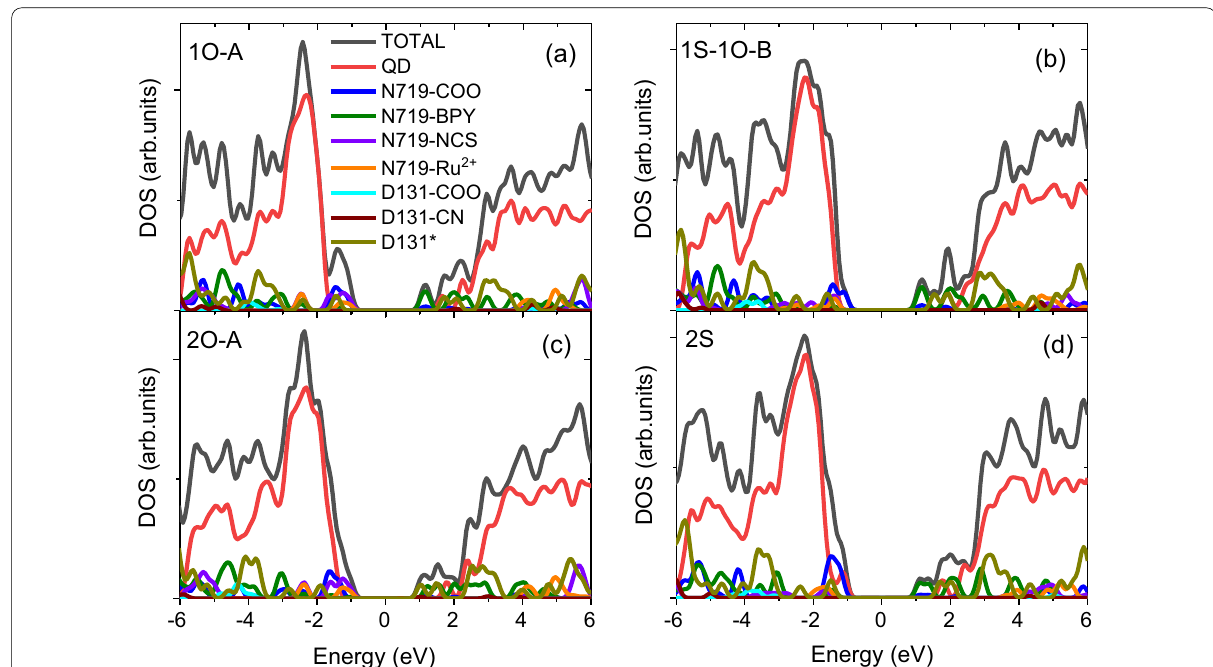
Fig. 4 PDOS of the selected binding geometries of N719 dye attached to the Cd 33 Se 33 QD@D131 dye composite in